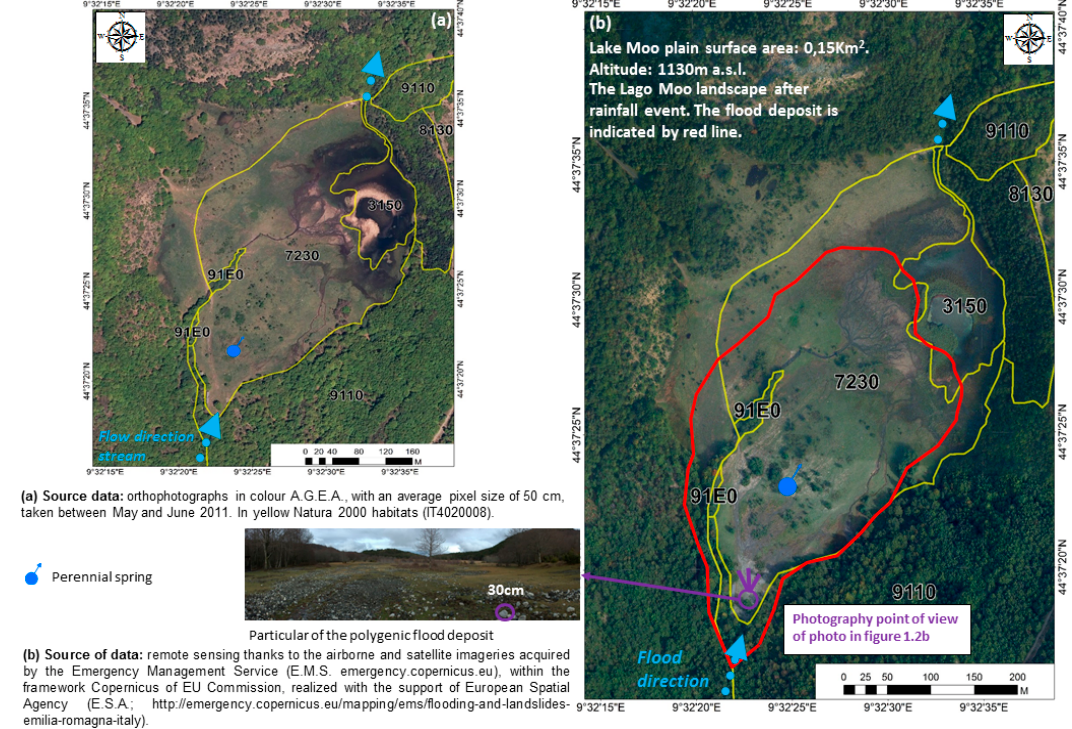
Figure 6. Satellite imagery before ( a ) and after ( b ) the high-discharge flood in September 2015. The yellow line defines the habitats of the Natura 2000 network (IT4020008 site code).